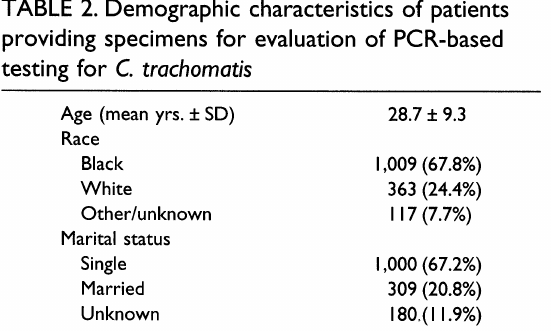
TABLE 2. Demographic characteristics of patients providing specimens for evaluation of PCR-based testing for C. trachomatis